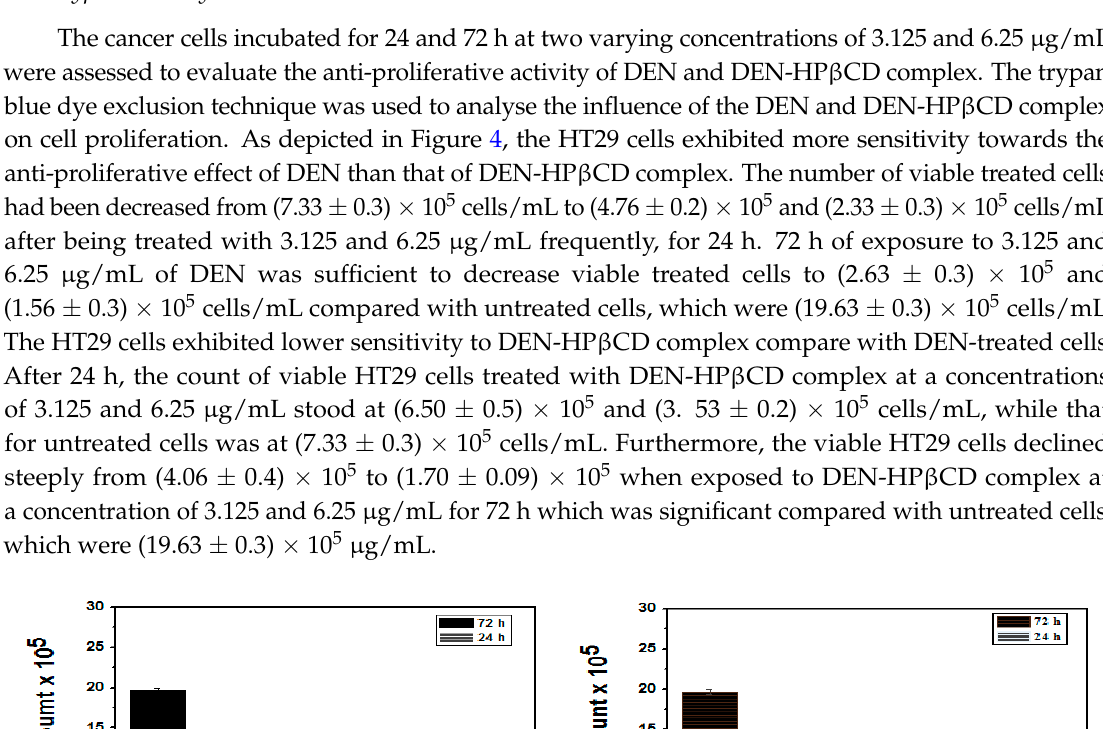
Figure 4. Trypan blue exclusion assay for cell viability of HT29 treated cells after 24 and 72 h of treatment with DEN and /or DEN-HP β CD complex. Mean ± standard deviation (SD). ( n = 3 well/treatment). * p < 0.05 compared with untreated cells.